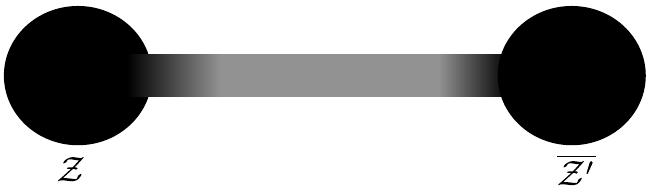
Figure 2 . Gluing of two mildly noncompact SQFTs Z and Z 0 . The orientation of Z 0 is reversed to Z 0